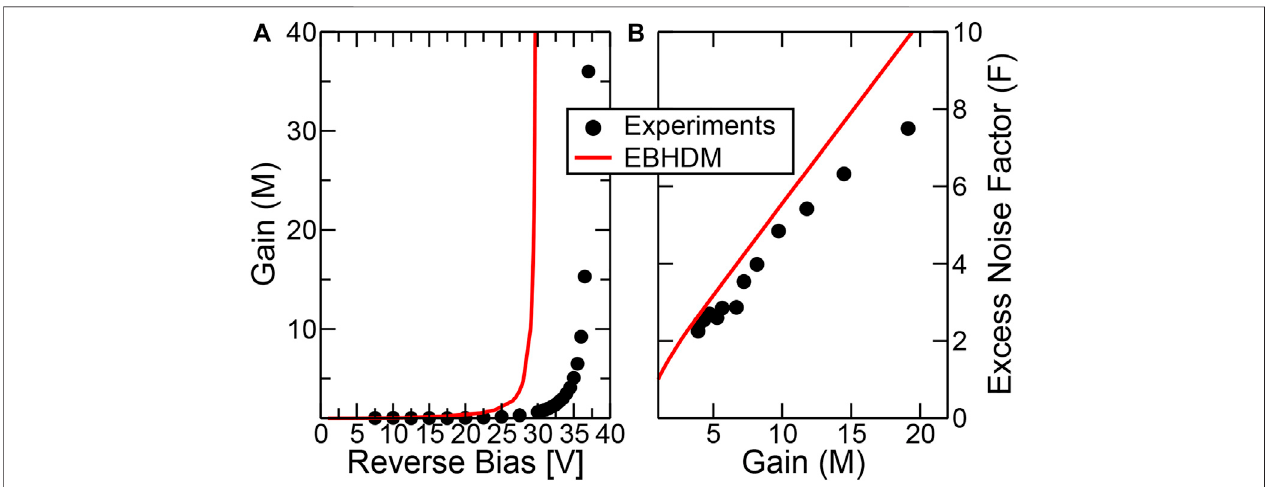
FIGURE11| Comparisonbetweenexperimental gainvs.voltage (A) andexcessnoisefactorvs.gain (B) andsimulationsusingtheEBHDMwithvariable λ e and λ h .